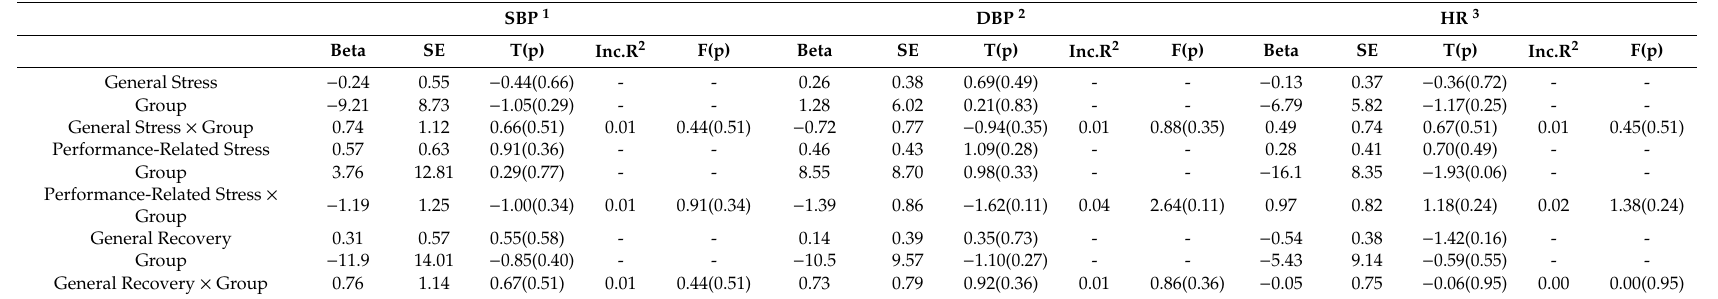
Table 2. Moderation analyses results for the prediction of SBP, DBP and HR at baseline.